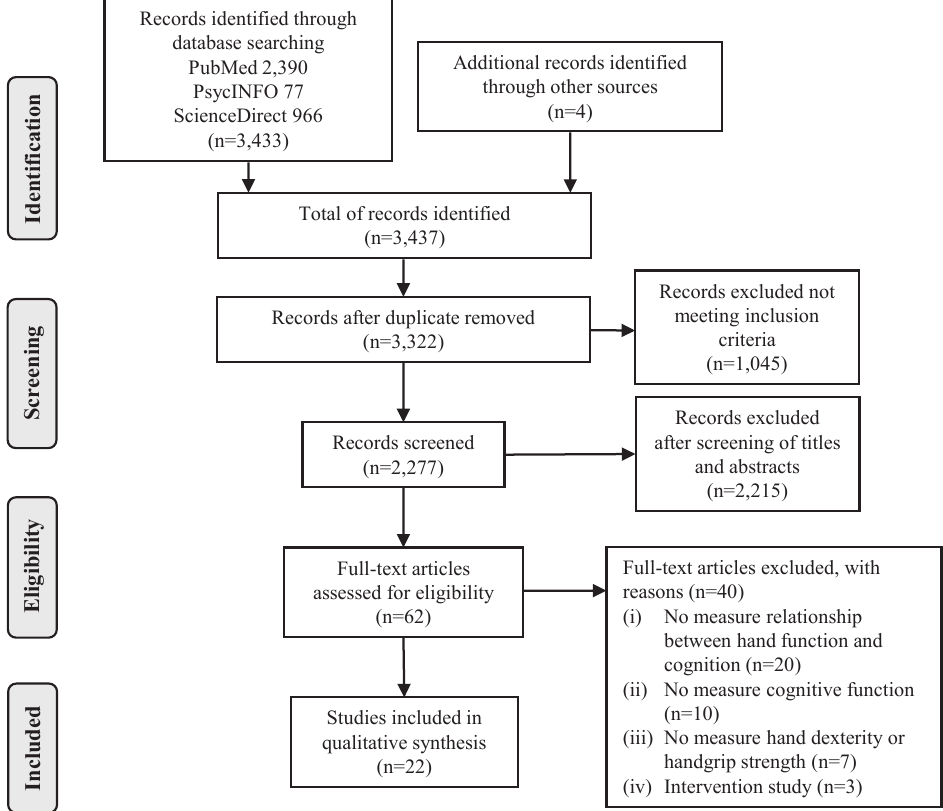
Figure 1. PRISMA fl ow diagram for the systematic